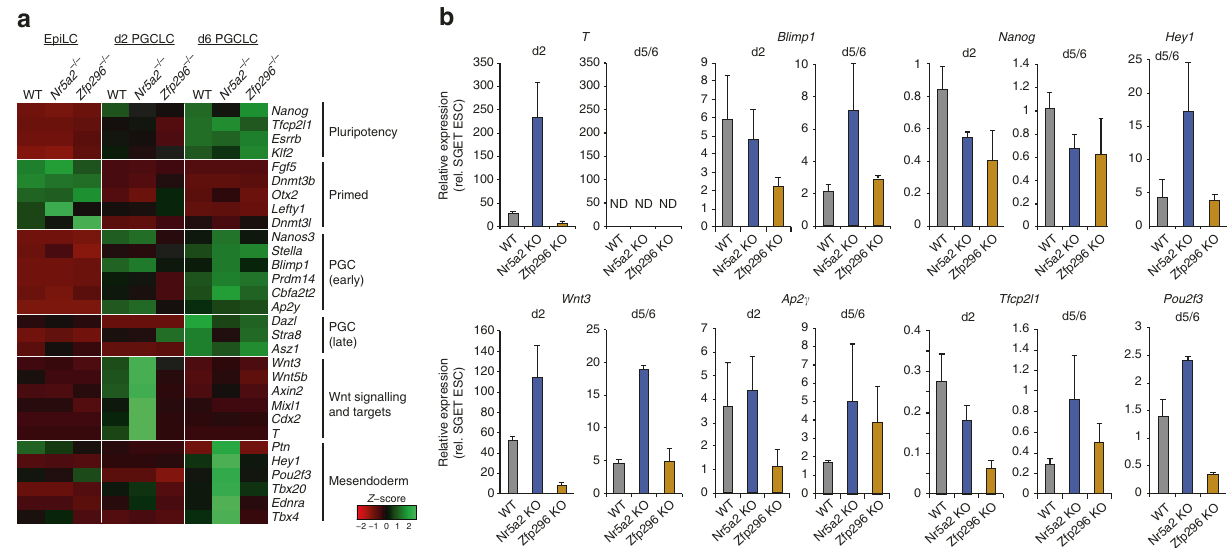
Fig. 5 Compound mis-regulation of WNT and germ cell genes in the absence of Nr5a2 and Zfp296 . a Heatmap showing change in mean expression pro fi le of selected genes from triplicate independent WT, Nr5a2 − / − or Zfp296 − / − lines during PGCLC induction by RNA-seq. b Quantitative validation of gene expression changes in PGCLC from WT, Nr5a2 − / − and Zfp296 − / − lines by independent qRT-PCR experiments. Error bars show s.e.m. of duplicate biological experiments, each comprising at least twelve independent replicate inductions. ND not the top 20. The absence of appropriate level WNT signalling could manifest as impaired activation of critical germline genes that are WNT and/or T targets 5 . Indeed, Zfp296 -null PGCLC at d2 exhibited a block in Blimp1 , Prdm14 Cbfa2t2a and Ap2 γ